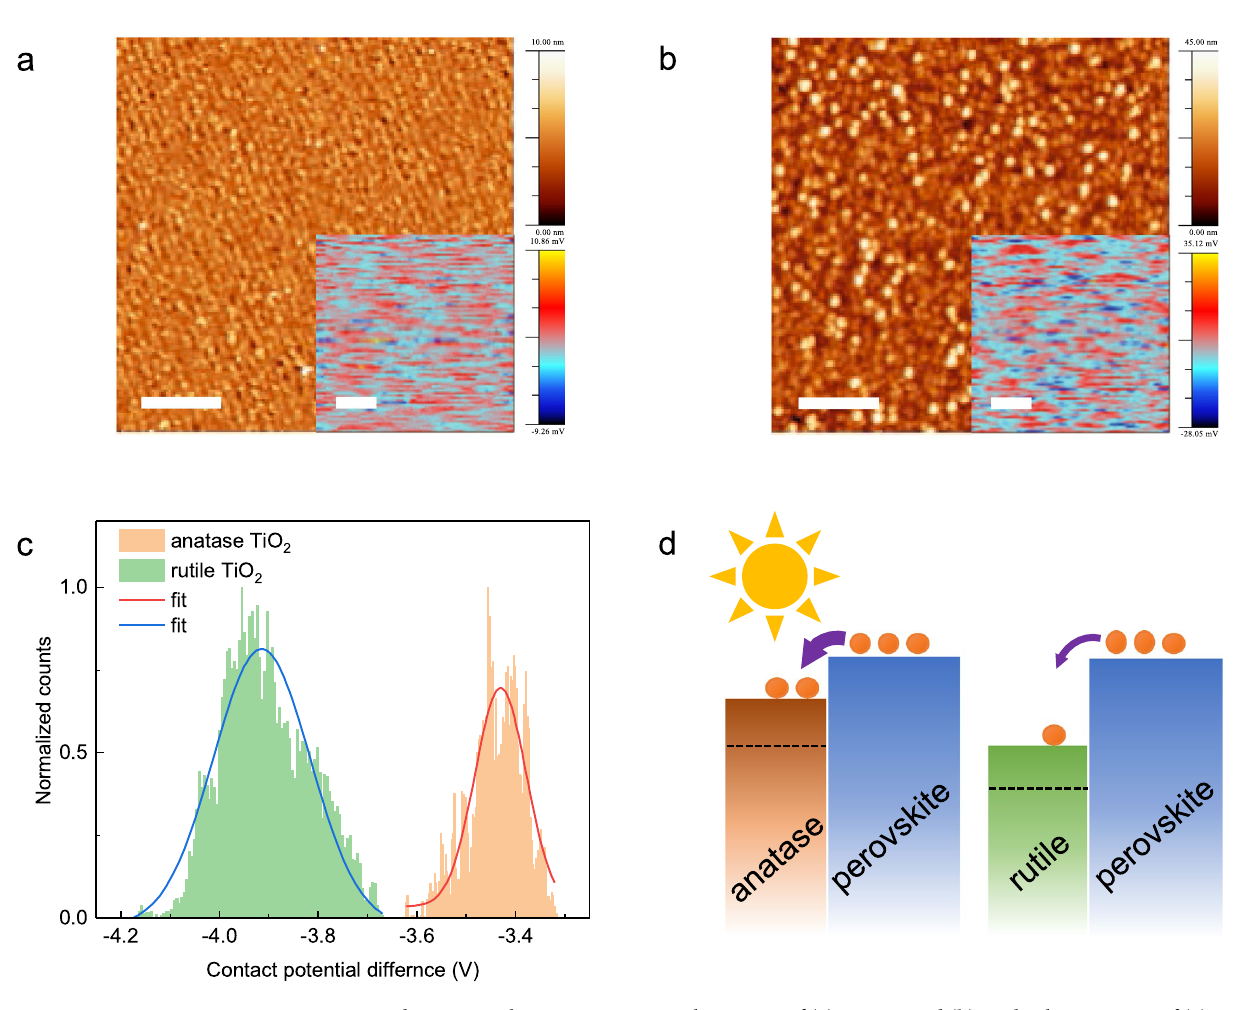
Figure 5. AFM and KPFM analyses. AFM topography images of ( a ) anatase and ( b ) rutile phases. Insets of ( a ) and ( b ) show the CPD maps for the corresponding topographies. Scale bar indicates 1 µm. ( c ) CPD distribution of anatase and rutile phases. Lines indicate Gaussian distribution fitting results. ( d ) Illustration of the band diagram of perovskite on the anatase and rutile phase under illumination. Only the conduction bands of the ETLs was shown to more clearly indicate the electron transporting behavior. The thickness of arrows and orange dots indicate the charge transport at the interface and the electrons,